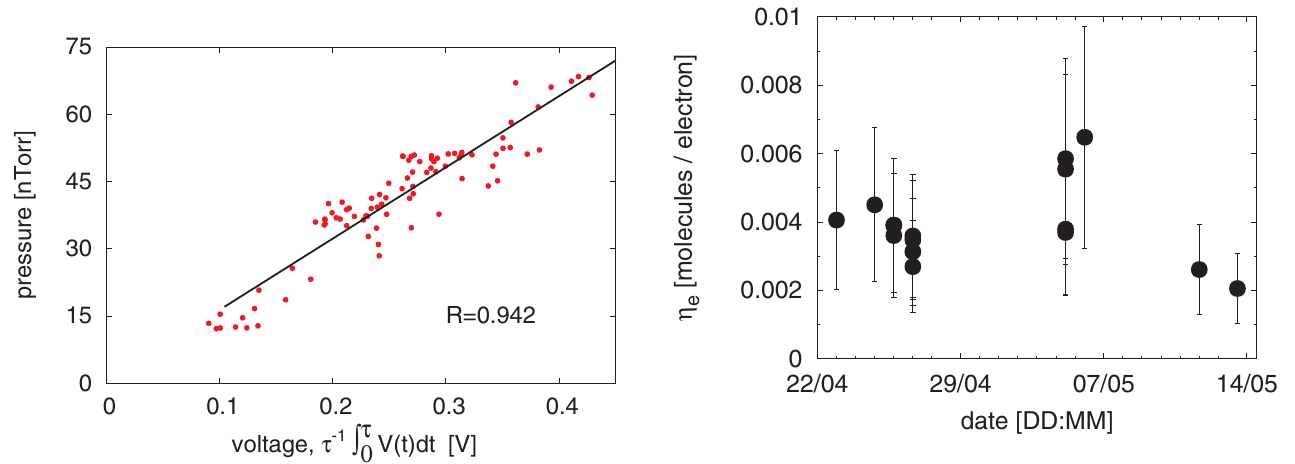
FIG. 10. (Color) Linear fit (black line) to the experimental points (red dots) shown in Fig. 7. As for the unbaked surface, a linear relation between the electron signal and the pressure is confirmed.